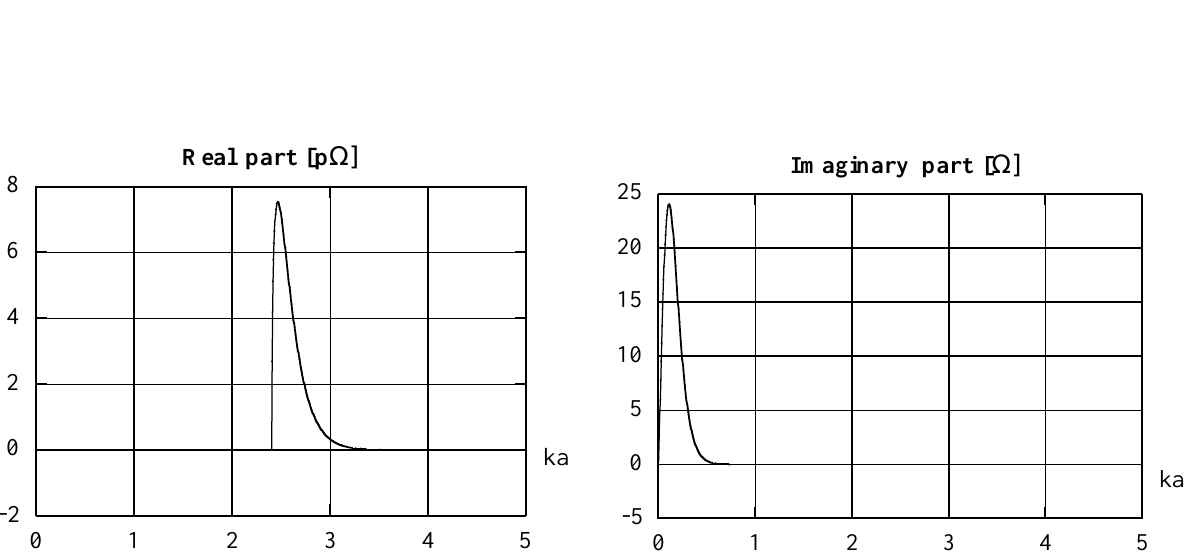
FIG. 7. Real and imaginary parts of the longitudinal coupling impedance in the case (cid:119) (cid:173) (cid:51) (cid:121) (cid:53) and bg (cid:173) (cid:49) (cid:121) (cid:49)(cid:48) .